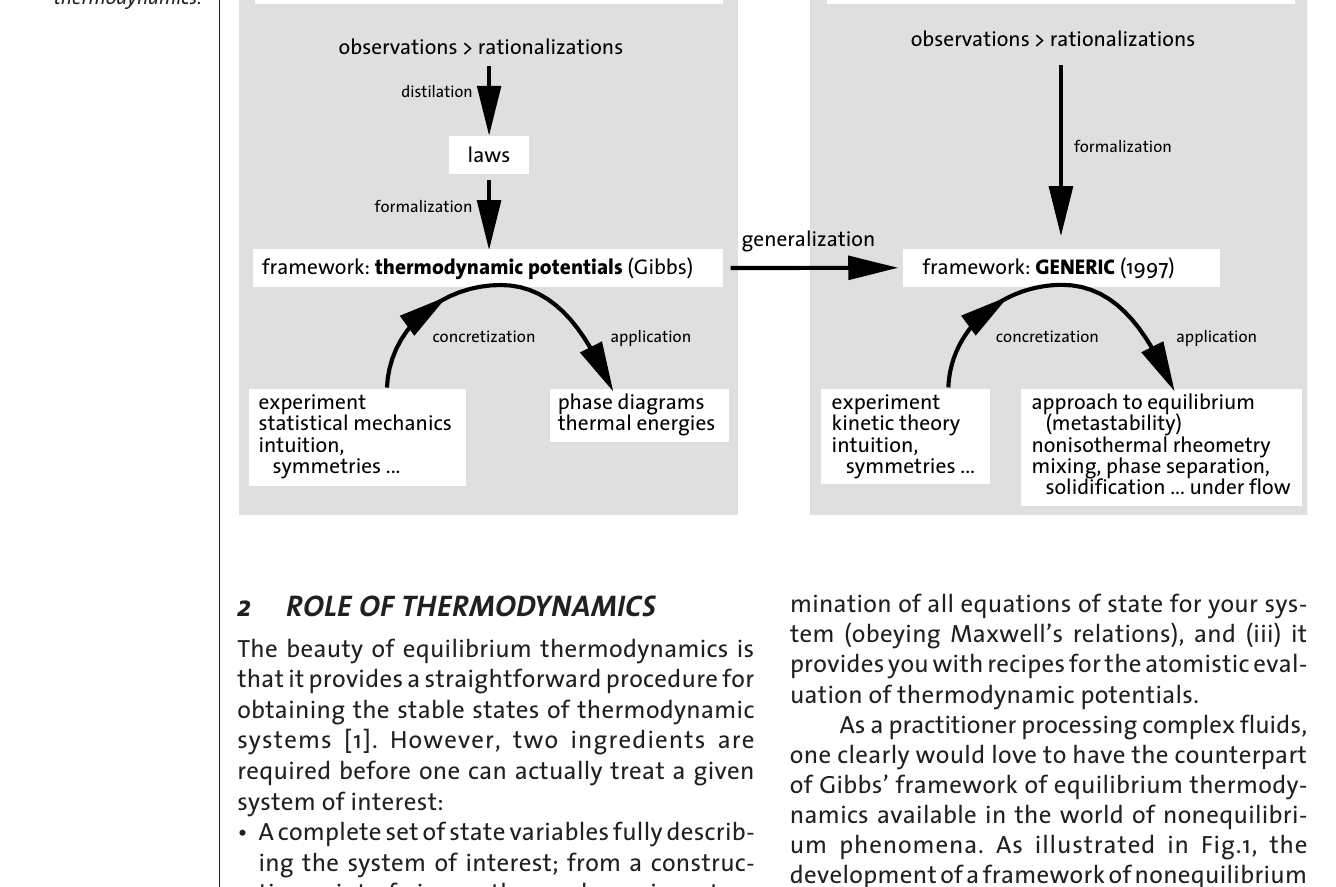
Figure 1: Framework of